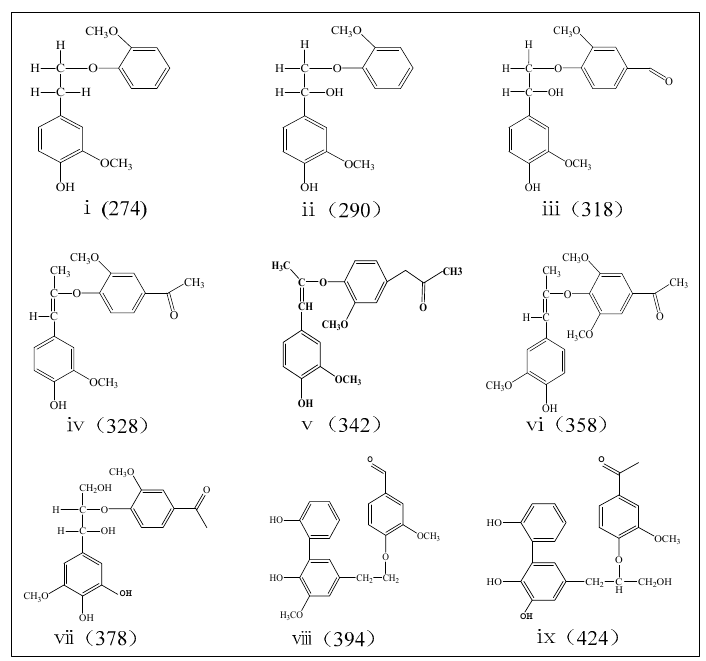
Figure 3. Proposed chemical structure of the aromatic oligomers detected by MALDI-TOF MS.